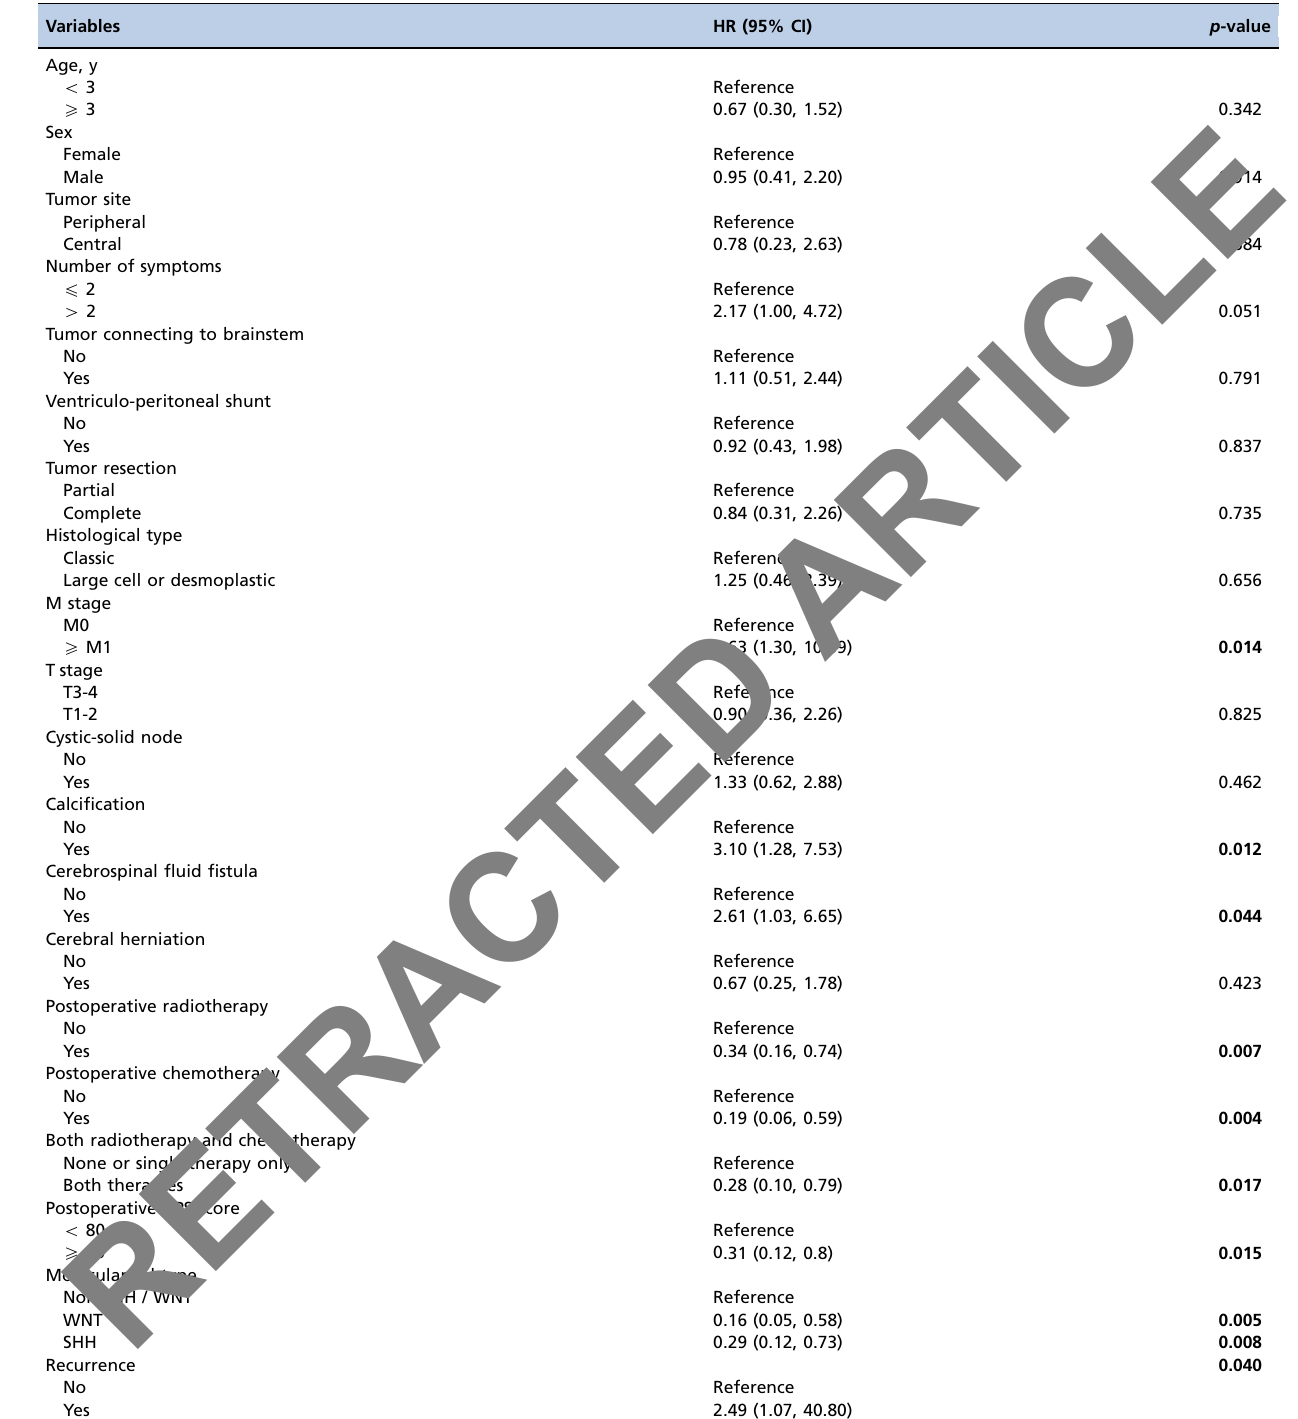
Table 2 - Univariate Cox proportional hazard model of factors associated with poor